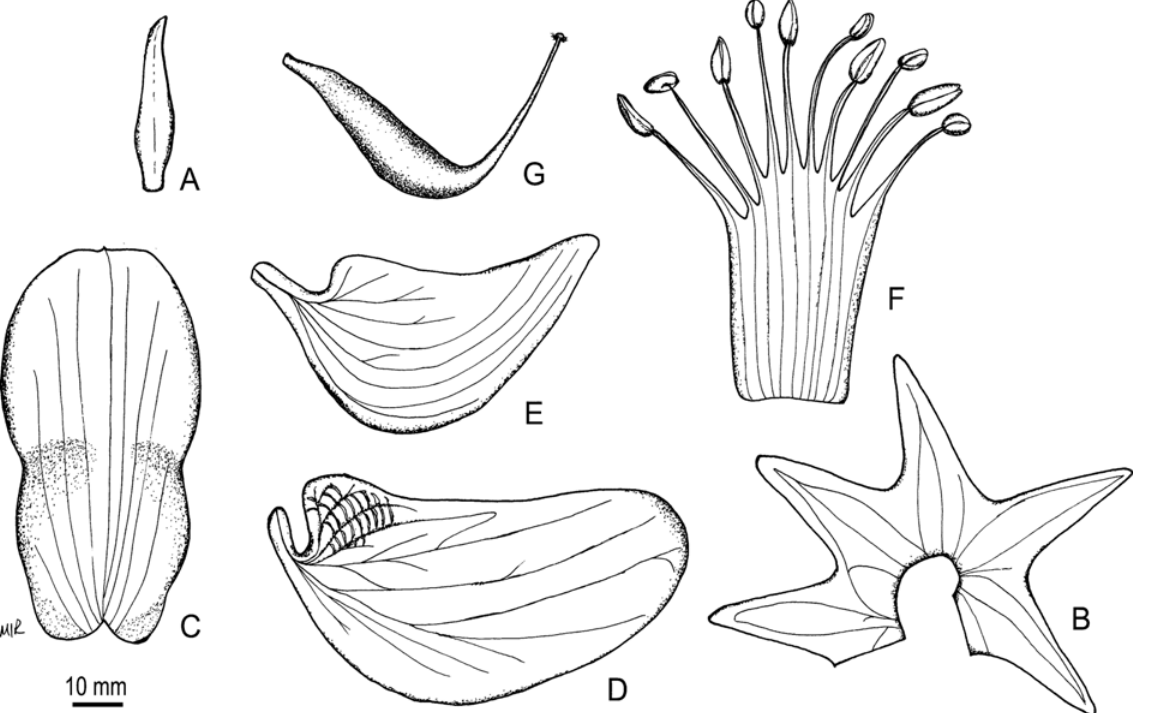
Fig 5. Flower morphology of Oberholzeria etendekaensis . Line drawings depicting the flower morphology. (A) Bract. (B) Calyx, opened out; lobes equal, dorsiventrally flattened. (C) Standard; strongly reflexed in the intact flower and lacking callosities. (D) Wing petal; longer than the keel and without a spur. (E) Keel petal. (F) Androecium, opened out; diagnostic for the genus is the stamens which are all fused into a tube that is closed above, and dimorphic anthers with five long, basifixed anthers alternating with five short, dorsifixed anthers. (G) Gynoecium. Voucher: Swanepoel 316 (WIND). Artist: M.M. le